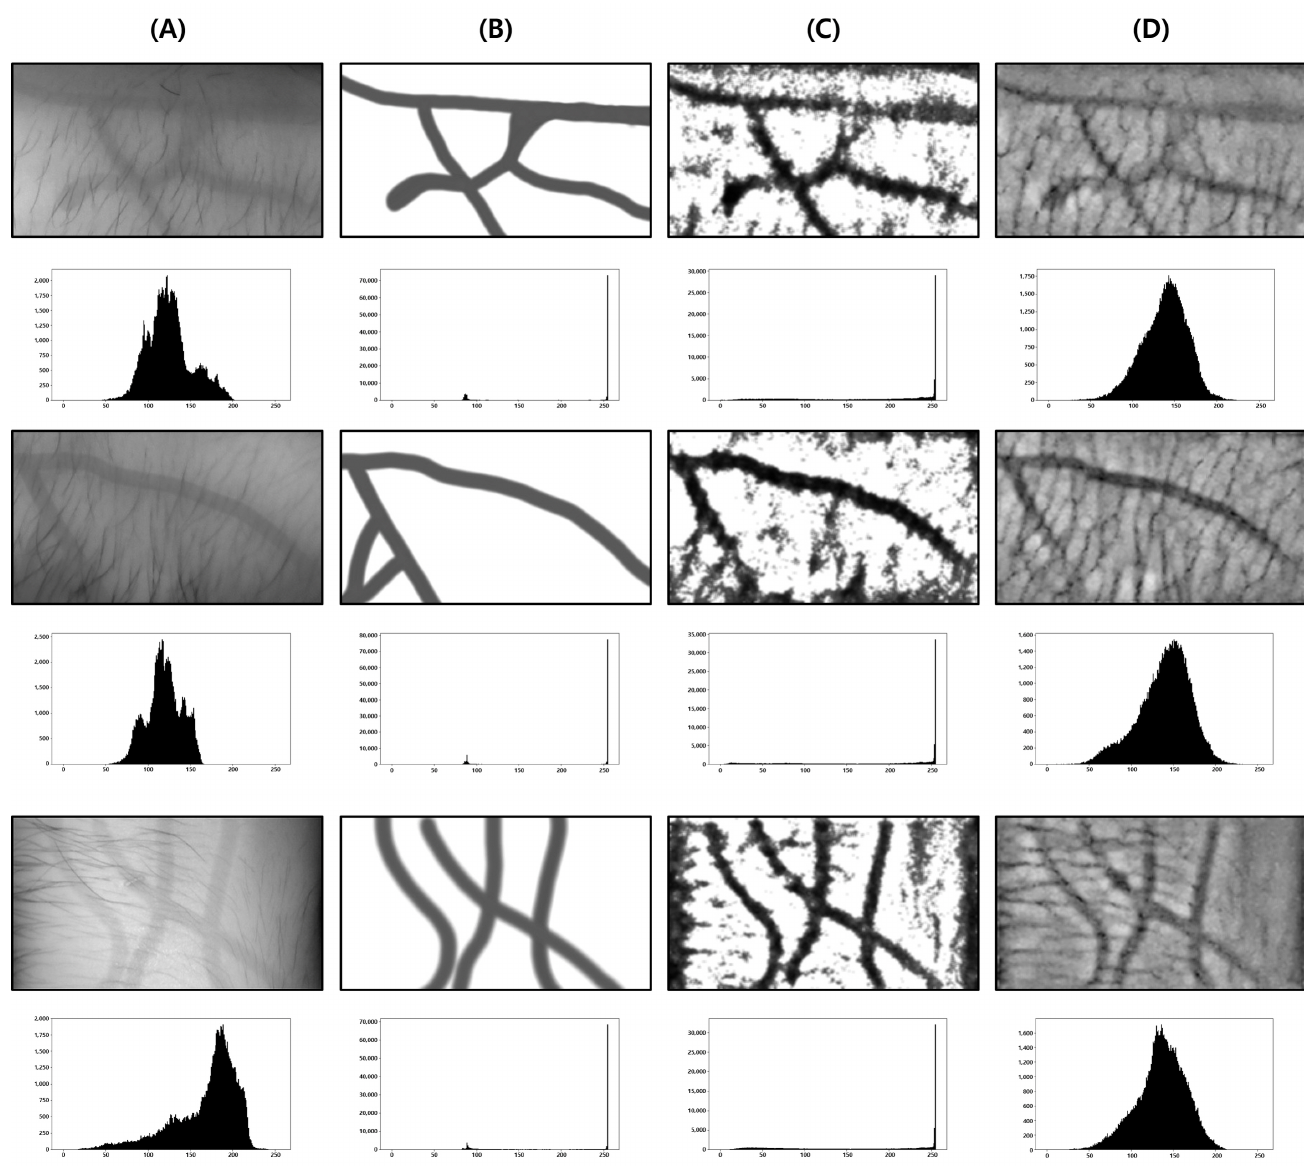
Figure 15. Image operation results with body hair noise: ( A ) is a test image created for algorithm verification, and ( B ) is an artificial blood vessel layer used to create the image. ( C ) is the resultant image of the proposed algorithm including the hair noise removal function, and ( D ) is the resultant image of the Veinvu-100